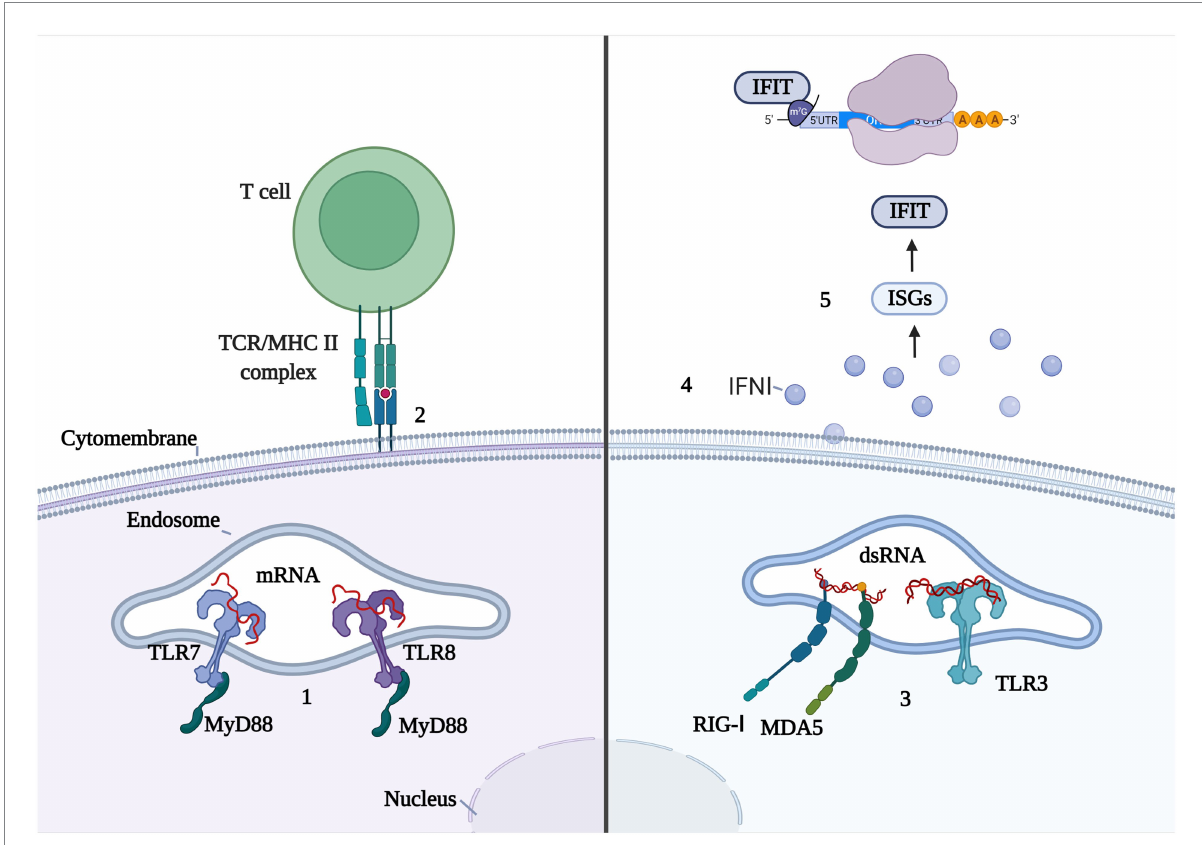
FIGURE 4 Double-edged sword of innate immune response with mRNA vaccine. 1.TLR7 and TLR8 recognize single chain mRNA and activate MyD88. 2. Innate immune cells activate CD4 + T cells through MHC II molecules to activate adaptive immune responses. 3.RIG-I, MDA5, and TLR3 recognize dsRNA. 4. Innate immune cells release IFNI and activate ISG. 5. ISG overexpresses IFIT, which binds to the mRNA cap or elF3 and prevents the mRNA translation